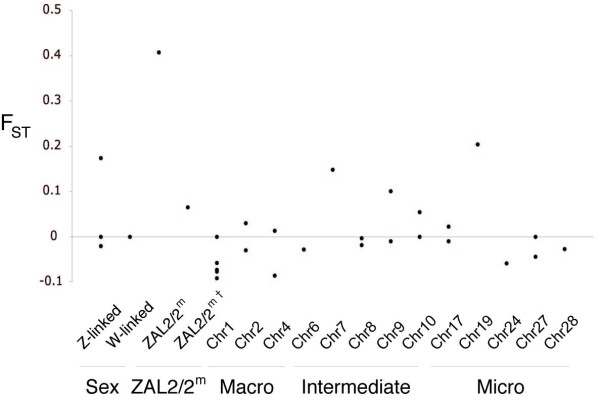
FST values between TS and WS white-throated sparrow groups across the genome. The ZAL2/2m data point represents FST within the inversion interval between the arrangements and is the only value to show significant population structure (p < 0.01). The ZAL2/2m† data point represents the FST outside the inversion on white-throated sparrow chromosome 2. Note that the chromosomes labeled as Chr refer to the predicted orthologous chromosome in chicken. Also note the negative FST values are an artifact of the method used to calculate this statistic using sequence comparisons and are not significantly different from 0.